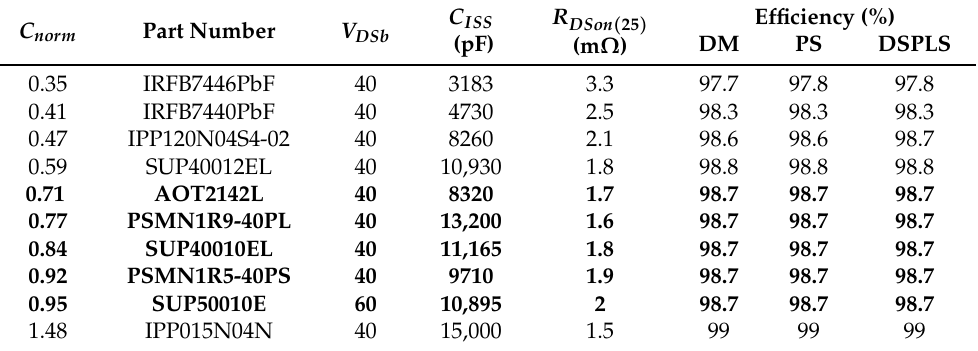
Figure 13. Pareto front for 800 W considering optimal and sub-optimal designs for scenario 1. Table 10. Comparison of optimal and sub-optimal solutions with same part number for all MOSFETs with each modulation technique, for 800 W. Reference values: C ref = 1, η ref =